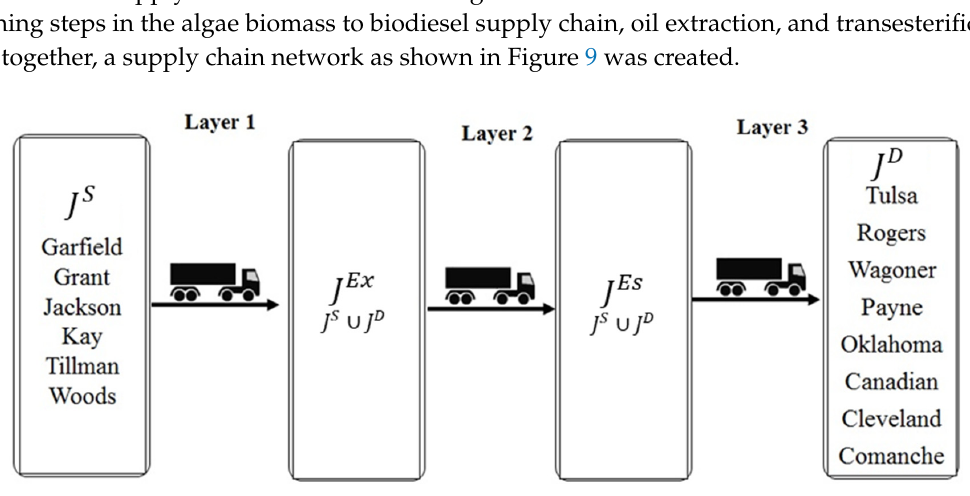
Figure 9. Network flow diagram of the algal biomass to biodiesel supply chain network for the state of Oklahoma. Supply locations ( J S ) are those in Table 2, and demand regions ( J D ) are those in Table 1. Both sets of locations are used as possible sites for extraction ( J Ex ) and transesterification ( J Es